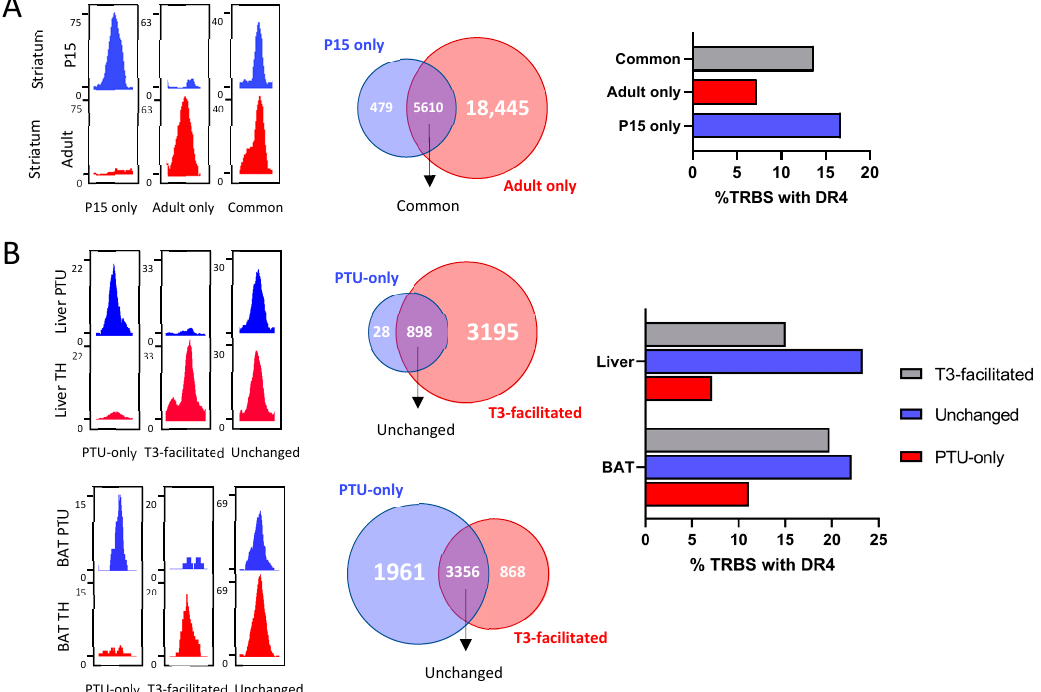
Figure 3. Plasticity of TR during development and T3 treatment. ( A ) (Left) Integrative Genome Viewer shots of TRBS categorized as only appearing in P15 striatum, adult striatum or present in both. (Middle) Venn diagram of TRBS present on each of the defined categories. (Right) Percentage of TRBS that possess a DR4 element. ( B ) ( Left) Integrative Genome Viewer shots of TRBS categorized as only present in the PTU condition, facilitated by T3 or present independently of T3 status. (Middle) Venn diagram of TRBS present on each of the defined categories. (Right) Percentage of TRBS that possess a DR4 element. This analysis was carried out for the liver (top) and brown adipocytes (bottom).